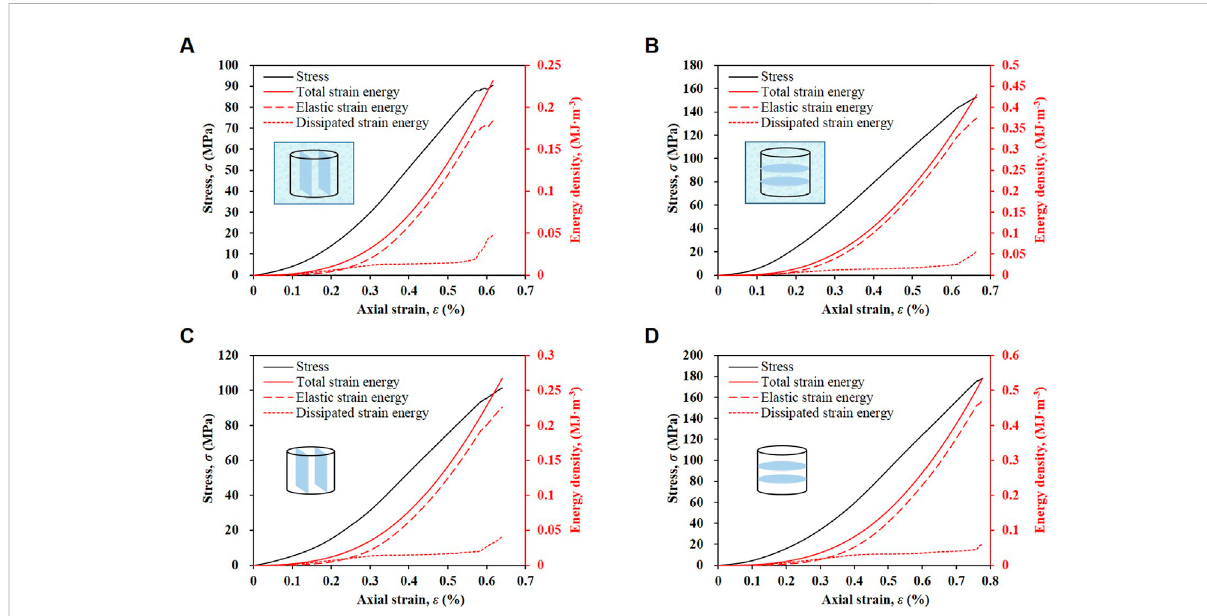
FIGURE 10 Relationcurvesbetweenstrainenergydensityandaxialstrainofrocksamplesunderdifferentinitialconditions (A) Samplewithverticalinterlayer after immersion (B) Sample with horizontal interlayer after immersion (C) Undisturbed sample with vertical interlayer (D) Undisturbed sample with horizontal